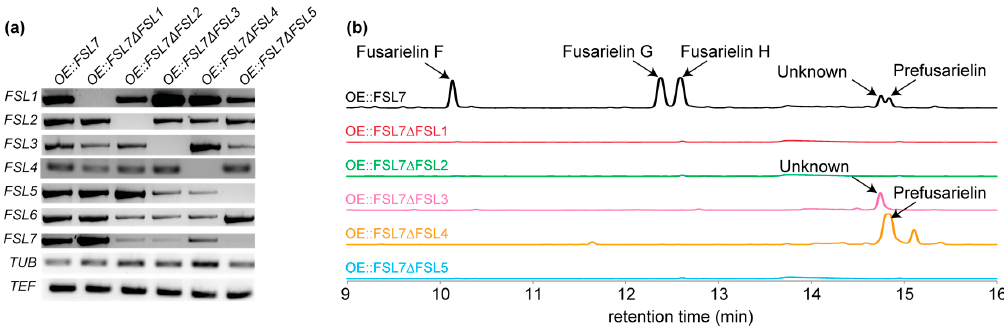
Figure 2. Transcription and metabolite analyses of OE:: FSL7 and OE:: FSL7 Δ FSL1 - 5 . ( a ) Reverse transcription polymerase chain reaction (RT-PCR) of FSL1 - 7 , the translation elongation factor 1 α (TEF) and β -tubulin (TUB) were included as controls; ( b ) Partial HPLC-UV chromatograms measured at 249 nm.